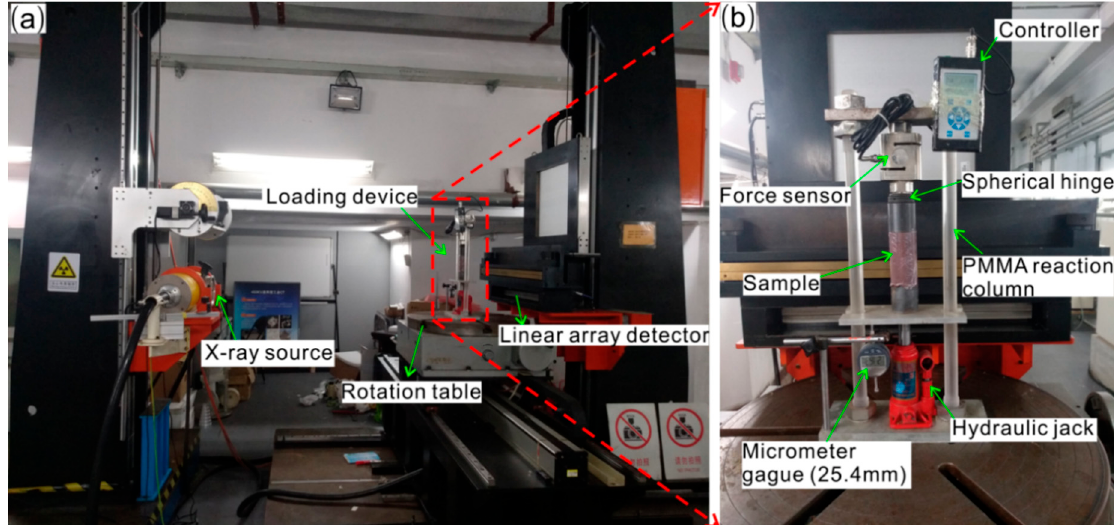
Figure 5. The testing system used for the cemented waste rock backfill (CWRB) sample. ( a ) Photo of 450 kV X-ray CT machine, which is mainly composed of X-ray source, rotation table, CCD, and detector; ( b ) Photo of the loading device, which is transparent to X-rays and composed of the force sensor, sample, micrometer, spherical hinge, PMMA reaction column, and hydraulic jack.